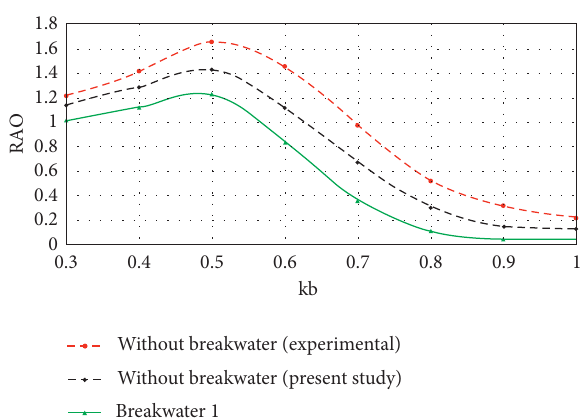
Figure 13: RAO curve for a heaving pontoon, with and without breakwater number 1.